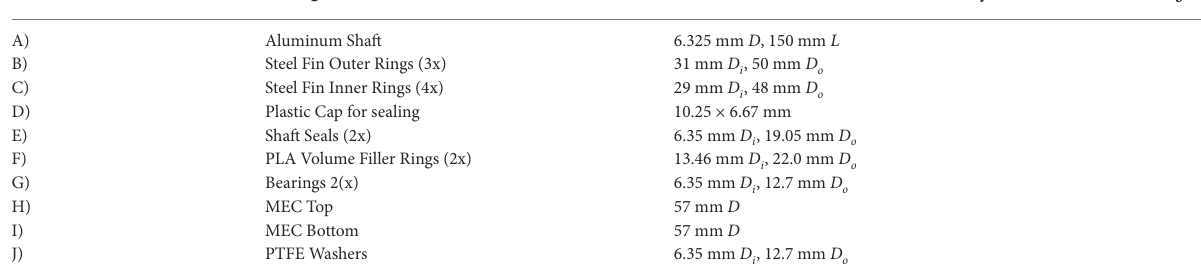
TABLE 1 AbillofmaterialsfortheinteriorMECassembly.